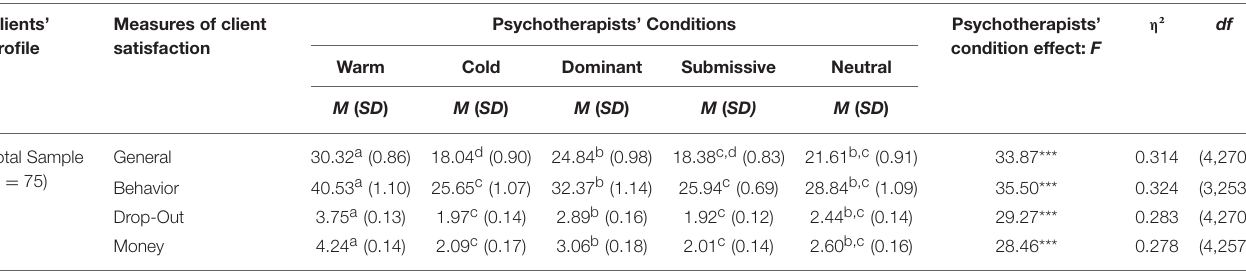
TABLE 2 | Simple effects of “psychotherapists’ conditions” (within-subjects), for each satisfaction measure. Clients’